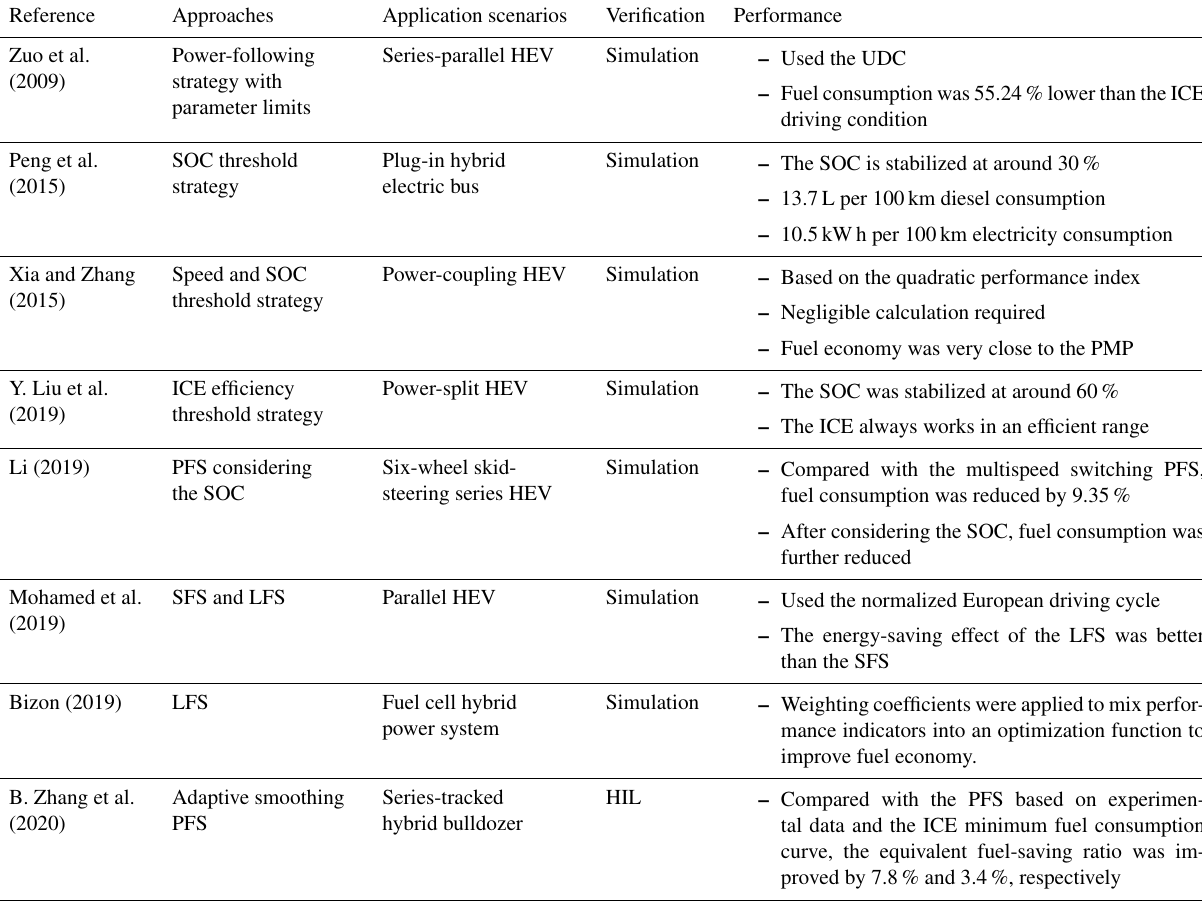
Table 2. Summary of exemplary works on deterministic rule-based EMSs